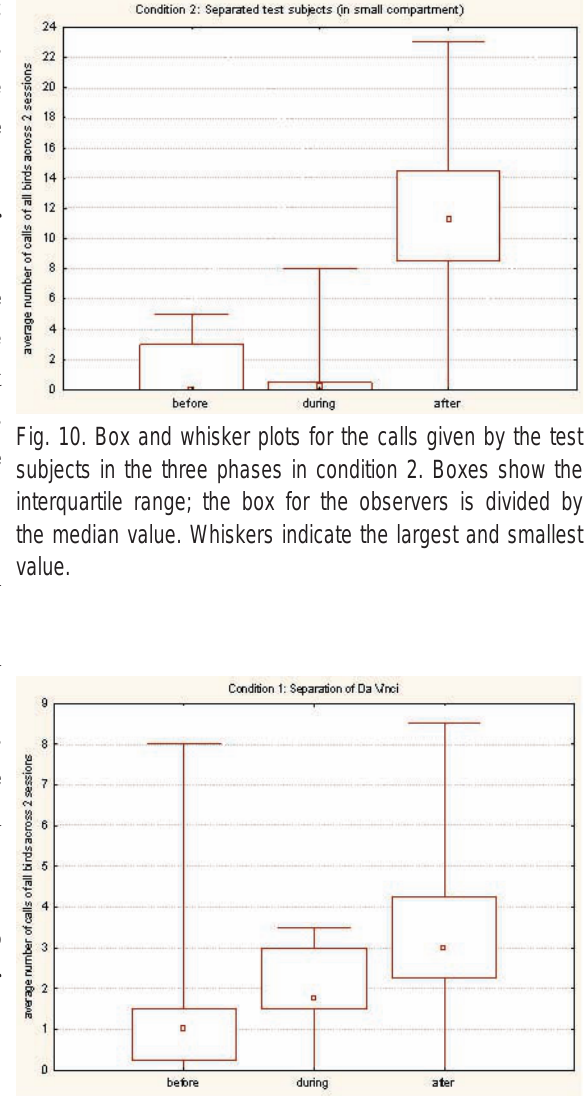
Fig. 11. Box and whisker plots for the calls given during the separation of one bird in condition 1. Boxes show the interquartile range; the box for the observers is divided by the median value. Whiskers indicate the largest and smallest